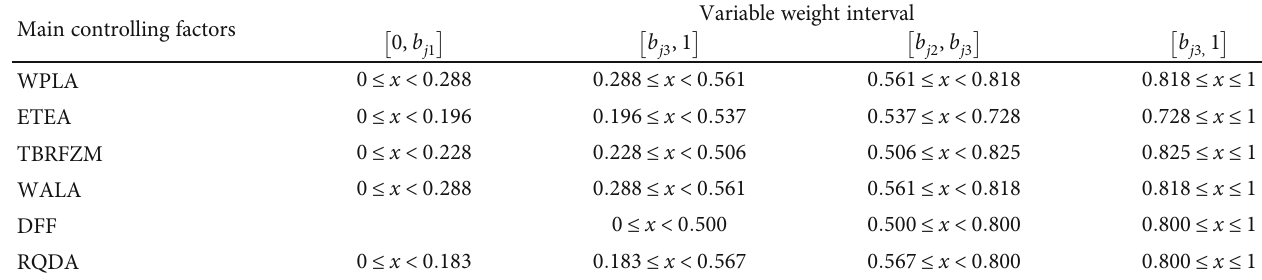
Table 1: Variable weight interval of main control factors.